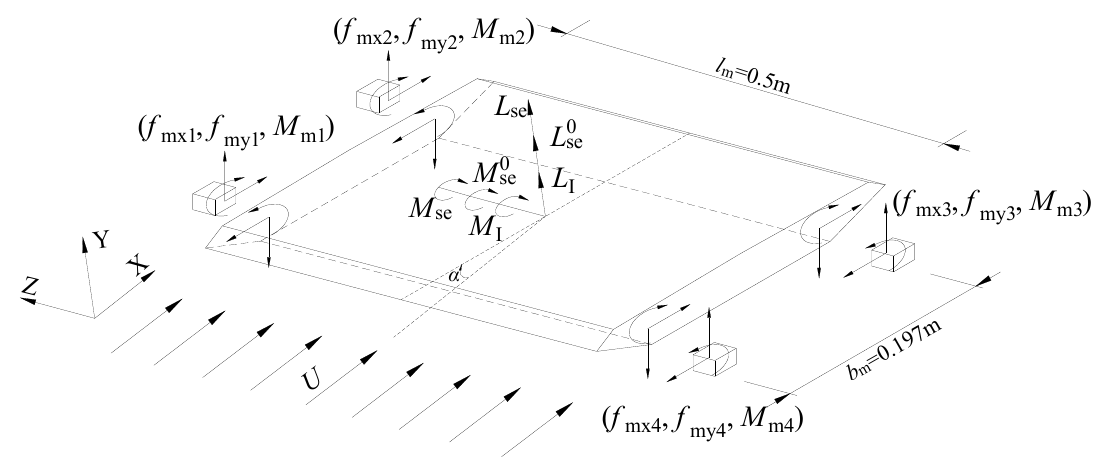
Figure 19. Definition and notation of the measurement technique of aerodynamic force.